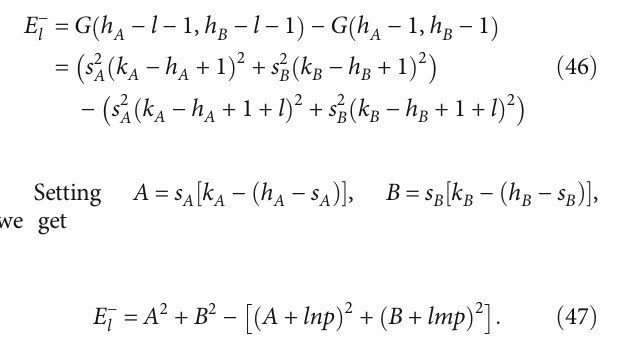
Figure 6: The fi rst excited state wave functions: ψ − ( m = 2, n = 3, p = 0 : 5